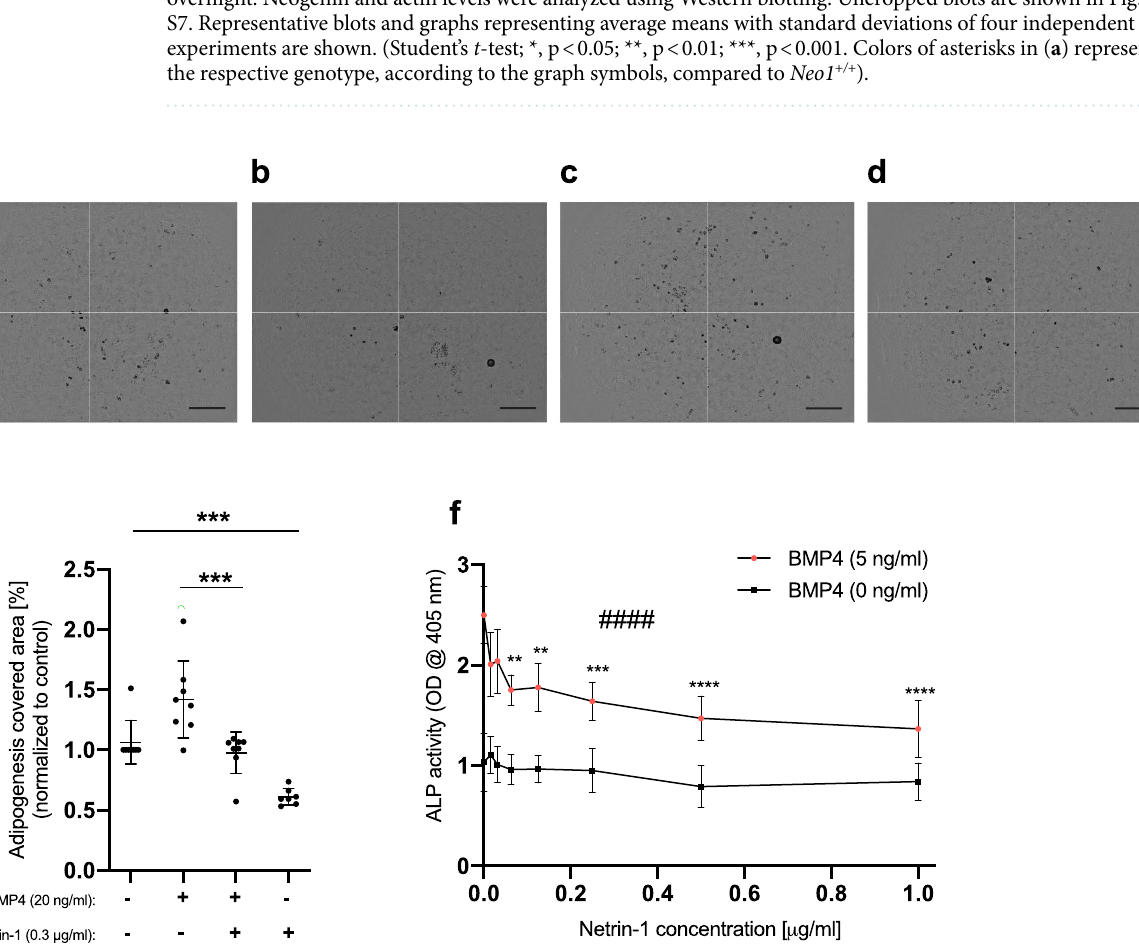
Figure 4. Netrin-1 inhibits adipogenesis and chondrogenesis in vitro. ( a – e ) Netrin-1 inhibits MEF adipogenesis. Wild-type MEFs were induced with an adipogenic cocktail together with or without 20 ng/ml BMP4 and/or 0.3 µg/ml netrin-1. After nine days, the cells were fixed, stained with Oil Red O, and imaged, and the staining was quantified. ( a – d ) Representative micrographs of MEFs treated with the adipogenic cocktail together with ( a ) no further additions, ( b ) BMP4, ( c ) BMP4 and netrin-1, and ( d ) netrin-1. Scale bars, 0.6 mm. ( e ) Quantification of the Oil Red O-stained areas as outlined in a-d. Shown are the means and individual values of eight independent experiments. (Student’s t -test: ***p < 0.001). ( f ) Netrin-1 inhibits chondrogenesis. ATDC5 cells were stimulated with BMP4 alone or in combination with different concentrations of netrin-1 for 72 h. Thereafter, chondrogenesis was assessed via an alkaline phosphatase (ALP) assay. The graph represents the average means with standard deviations of four independent experiments performed in duplicate. (One-way ANOVA: #### p < 0.0001. Post-hoc test with multiple comparisons [compared to netrin-1, 0 ng/ml] adjusted p-value: **p < 0.01; ***p < 0.001; ****p <